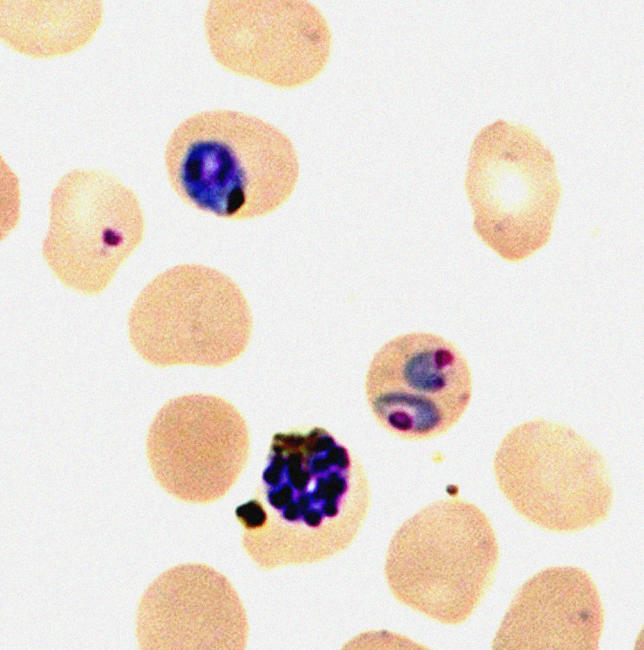

Plasmodium falciparum, the microbe that causes malaria, infects red blood cells. By analyzing different populations of the pathogen from around the world, researchers found clues to its genome structure that will be important for identifying genes that contribute to drug resistance and virulence